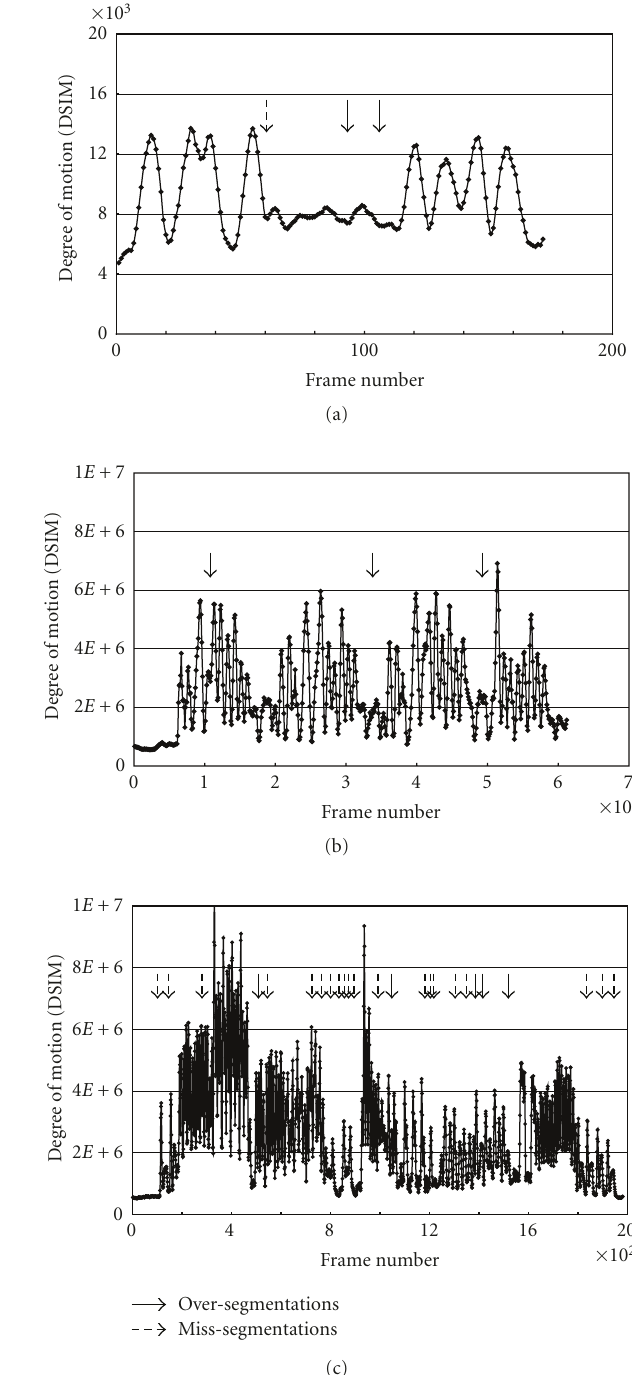
Figure 4: Degree of motion: (a) #1, (b) #2-1, (c)